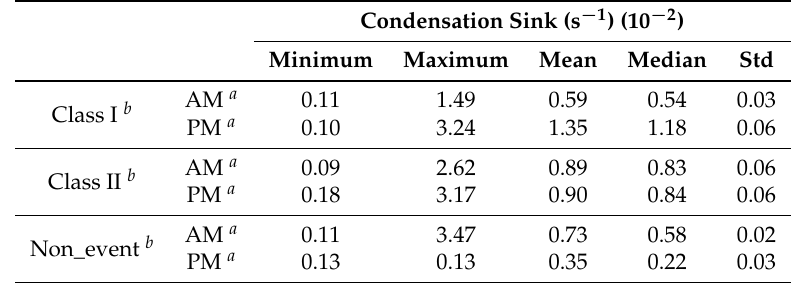
Table 3. Summary of the condensation sink (CS) on the Class I event days, the Class II event days and non-event days during the SO 2 − measurement 4